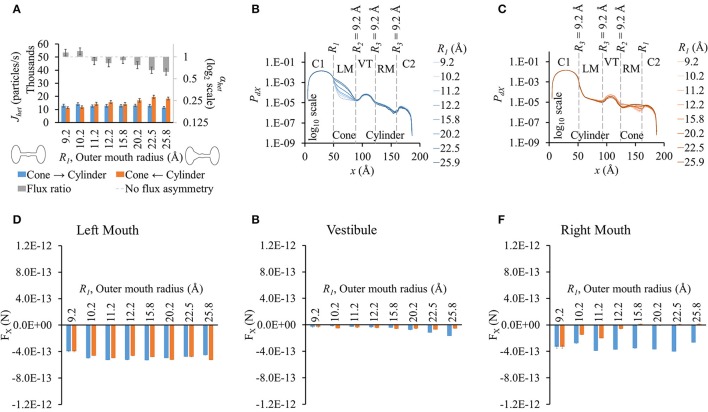
Properties of heterotypic pores with varying outer mouth size of conical section (R1-9.2-9.2-9.2). (A) LY fluxes and flux ratios simulated with constant concentration gradient of 2LY + 4Cs in cone to cylinder (blue bars) and cylinder to cone (orange bars) directions. The difference between Jhet,1 and Jhet,2 increased with larger conical mouth size. LY flux asymmetry increased with increasing outer mouth size of the conical section. (B,C)
PdX profiles in simulation (B) cone to cylinder direction and (C) cylinder to cone direction. (D–F) Average force per LY particle in (D) left mouth, (E) vestibule, and (F) right mouth. FX was in the -x direction in all sections of the pore. (D) FX magnitudes in the left mouth in either direction were almost equal for different pore mouth sizes. (E) FX magnitudes in the vestibule rose in the cone to cylinder direction with increase in R1. (F) The right mouth had high differences in FX magnitudes between the two directions with FX magnitude dropping with increasing R1 in the cylinder to cone direction.